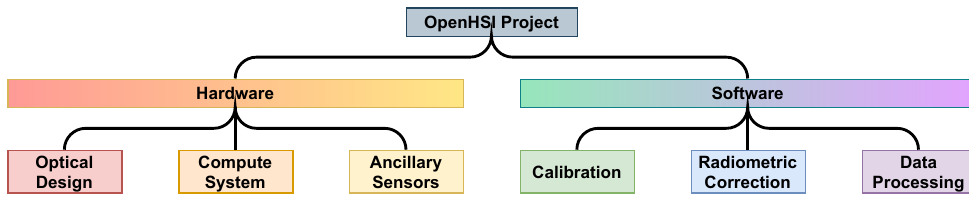
Figure 1. OpenHSI project